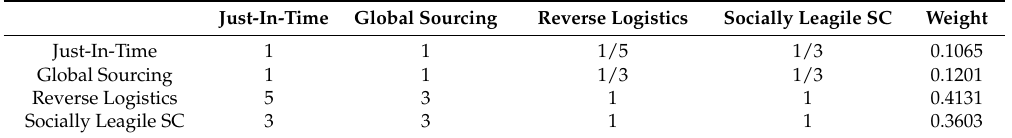
Table A9. Pairwise Comparison of Alternative w.r.t. sub-criterion Recycling Revenue.